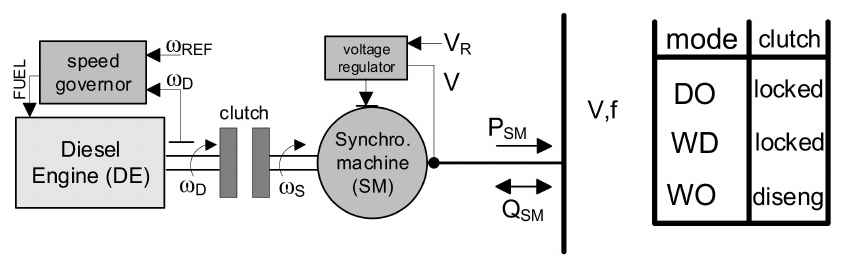
Figure 5. Clutch-type diesel generator